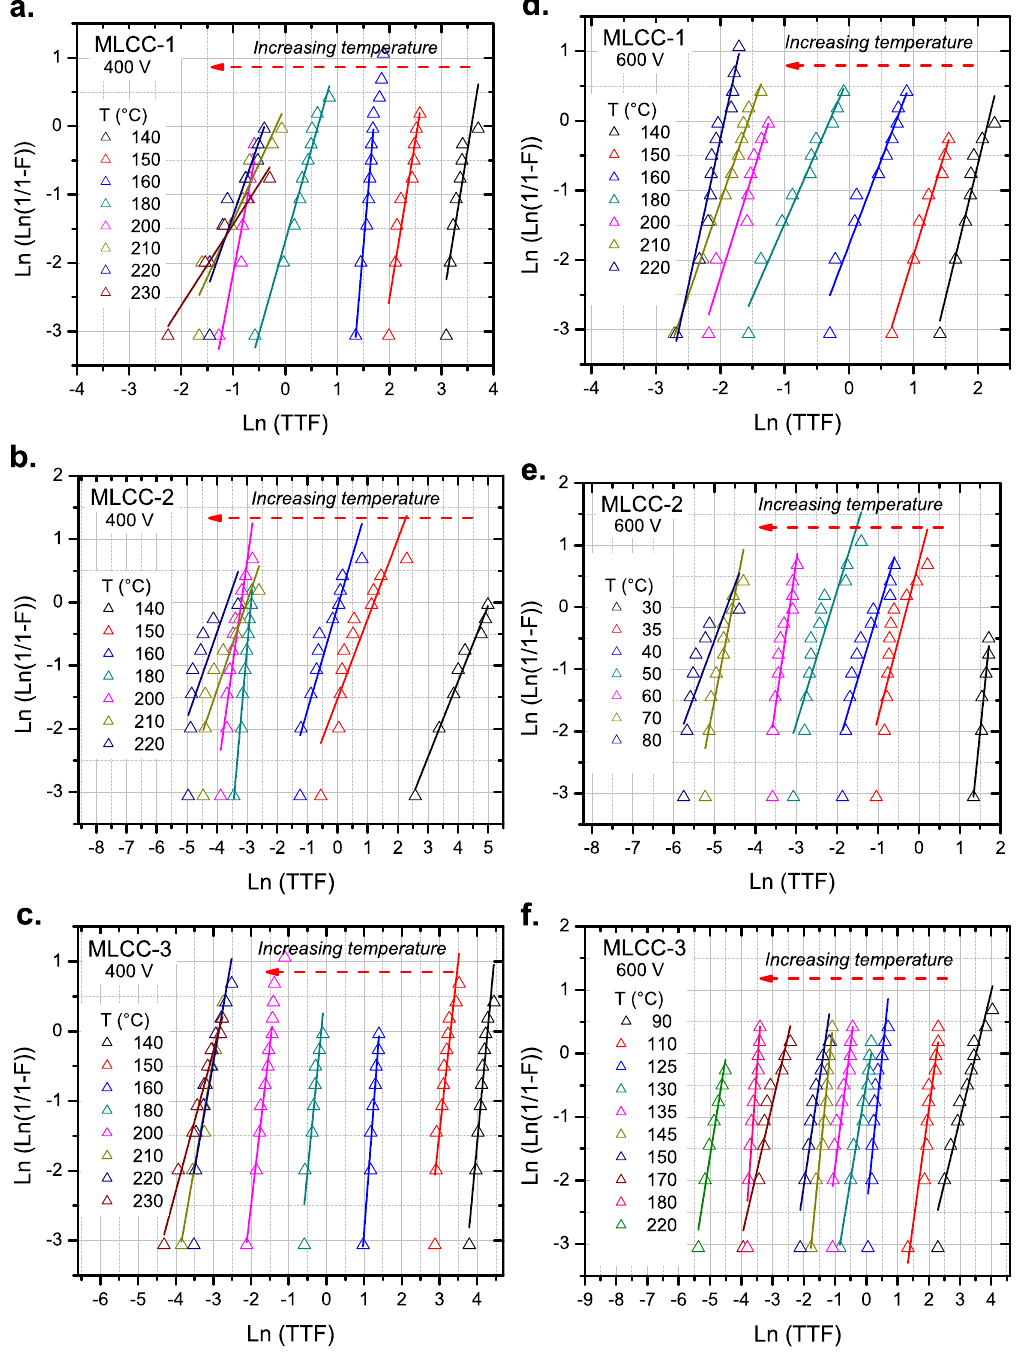
Figure 9. Weibull plot for MLCCs tested under a wide range of temperatures and different electrical stresses: ( a ), ( b ), and ( c ) 400 V; ( d ), ( e ), and ( f ) 600 V. Lines correspond to the linear fit used to determine the scale parameter ( α ) of the Weibull distribution. The increase of the temperature shifts the dielectric breakdown of the sample to lower times-to-failure.